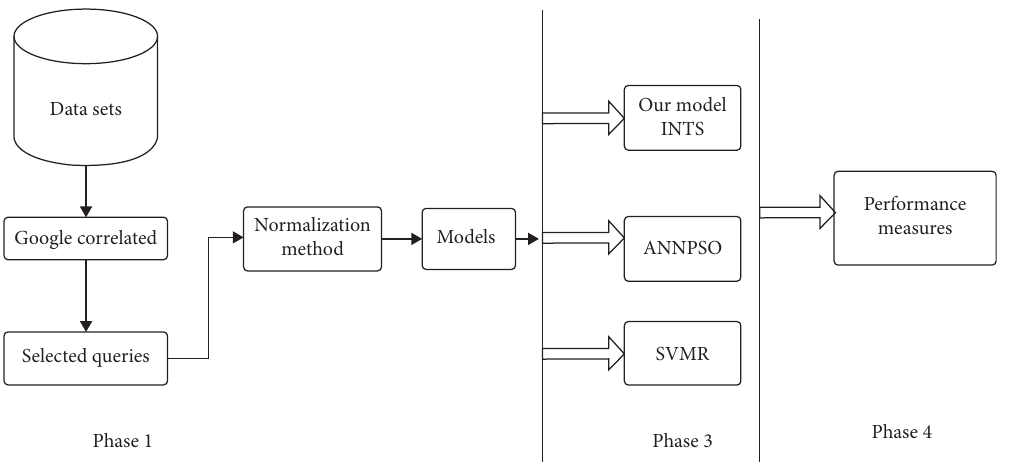
Figure 1: Generic framework of the proposed system.